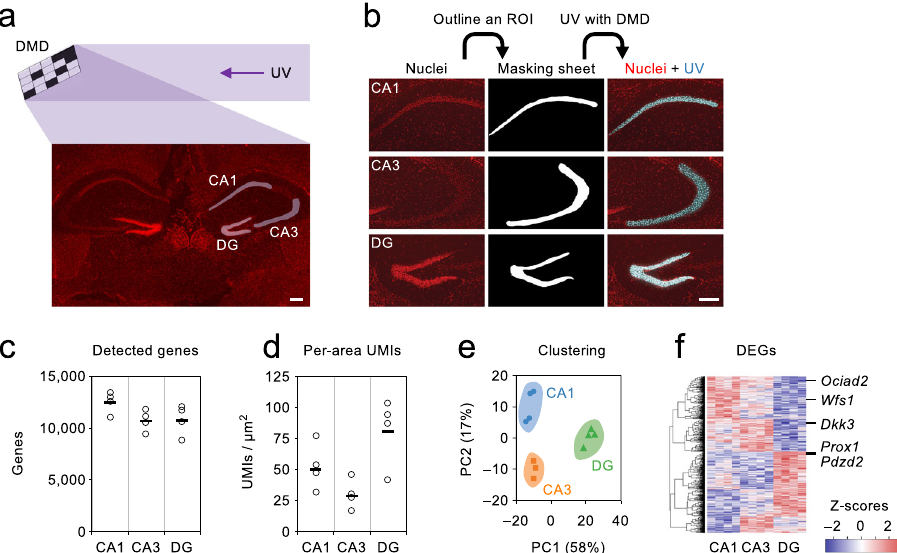
Fig. 3 PIC RNA-seq for hippocampus under DMD illumination. a Illustration of the experiments for DMD-assisted UV irradiation of CA1, CA3, or DG of mouse hippocampus. Samples were tested in four biological replicates. b Images of nuclei (red), resulting in masking sheets, and merged images of nuclei and DMD-assisted UV irradiation (blue) are shown. c , d Numbers of detected genes ( c ) and per-area UMIs ( d ) are shown, with the horizontal lines indicating the average of replicates. e Two-dimensional PCA for the expression pro fi les. f DEGs are clustered and shown in heat maps. Scale bars, 200 μ m. Source Data is available as a Source Data fi